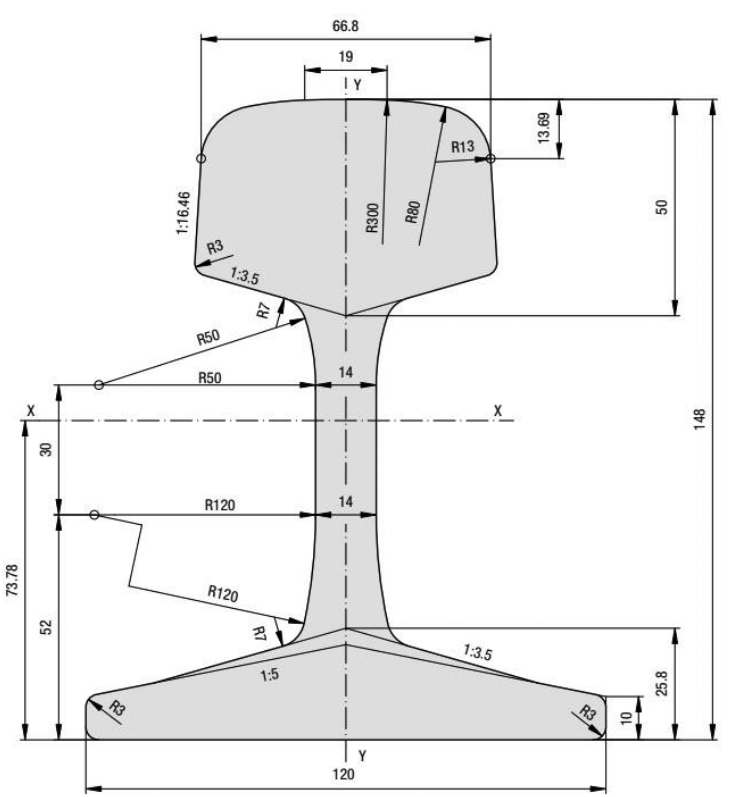
Figure 8. Cross-section of MAV48 rail profile (VoestAlpine Schienen GmbH, Profile